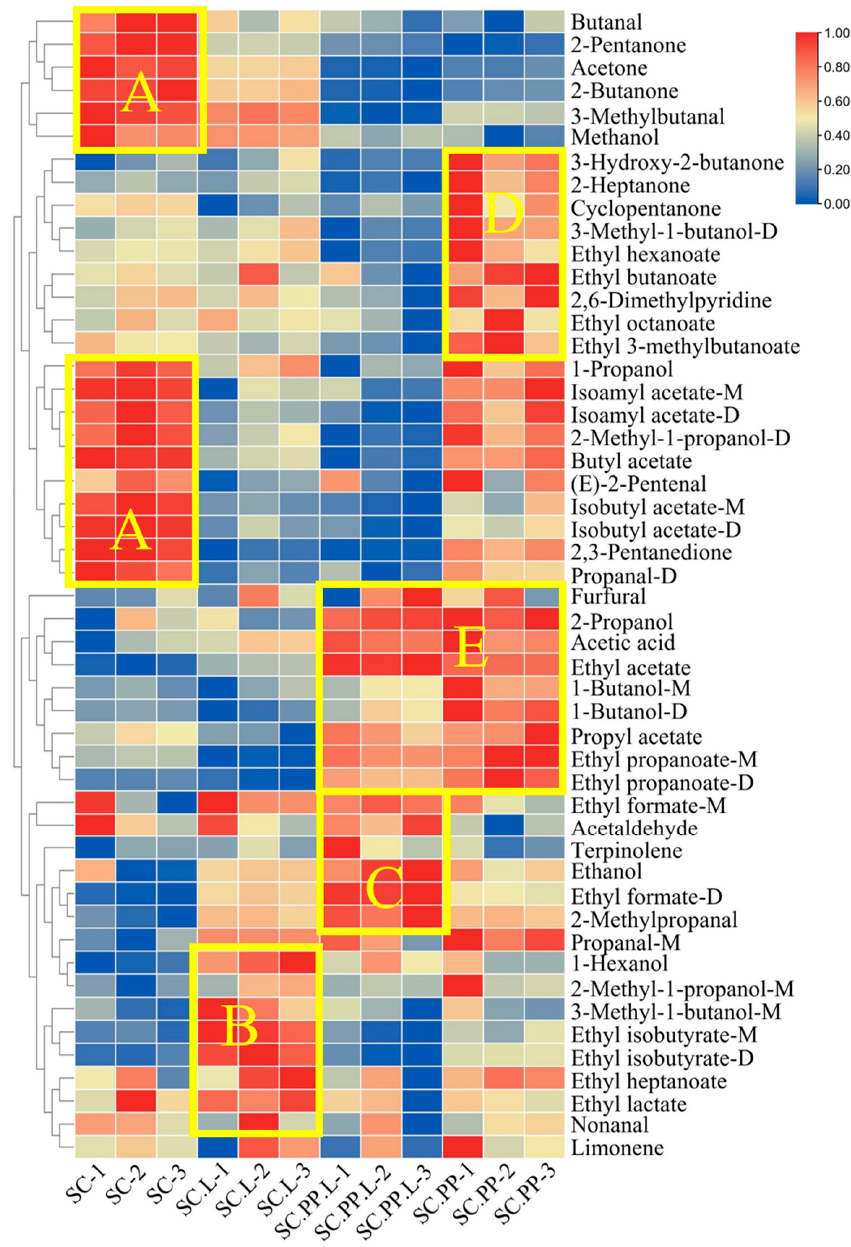
Figure 3. Heatmap analysis of volatiles taken from GC-IMS of the Jujube liquor. ( A ) Compounds with higher content in SC; ( B ) Compounds with higher content in SC.L; ( C ) Compounds with higher content in SC.PP.L; ( D ) Compounds with higher content in SC.PP; ( E ) Compounds with higher content in SC.PP.L and SC.PP; ( S. cerevisiae -‘SC’, S. cerevisiae and Lactobacillus -‘SC.L’, S. cerevisiae ,